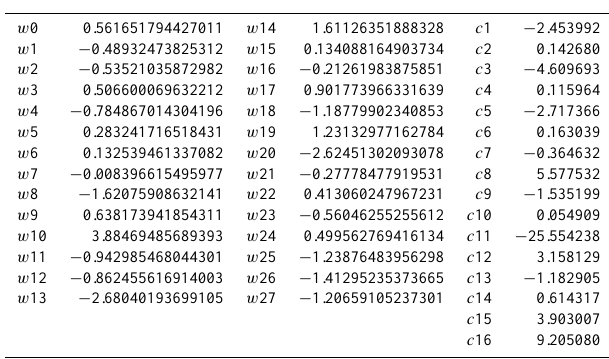
Table 2. Weights and normalization factors for the calculation of NO